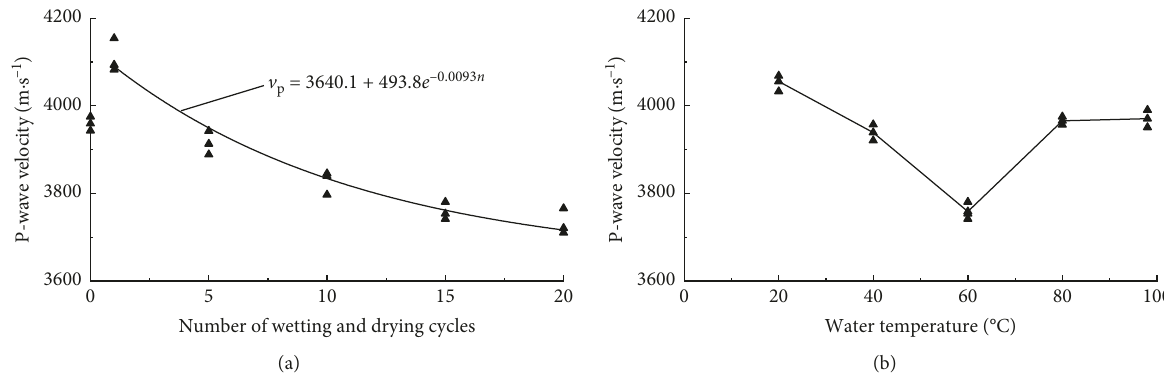
Figure 7: P-wave velocity variation after cyclic wetting and drying treatment. (a) P-wave velocity versus the number of wetting and drying cycles. (b) P-wave velocity versus water